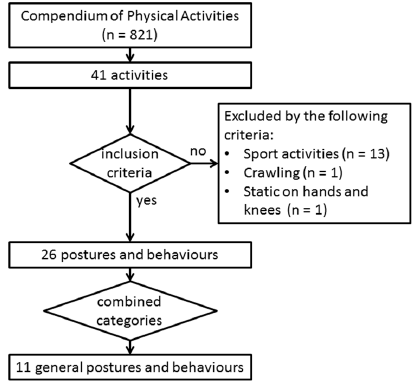
Figure 2. Flowchart depicting the selection of the 11 general postures and behaviours that are listed below in Table 2.